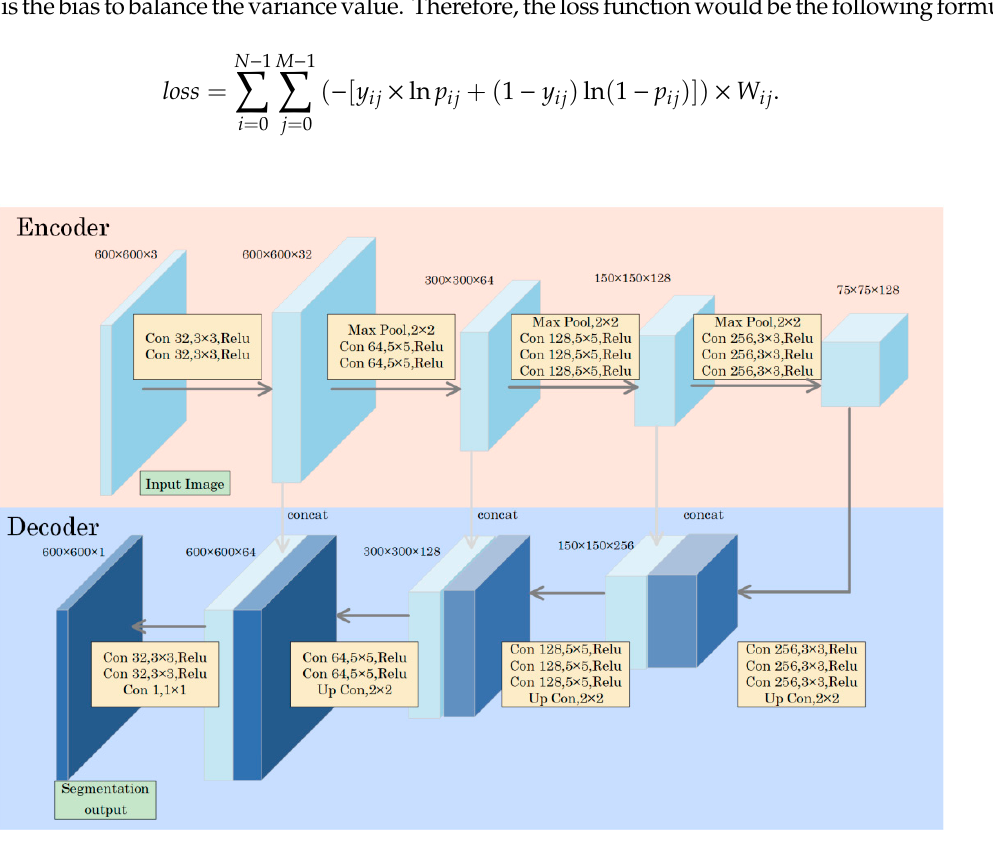
Figure 7. Proposed architecture of the segmentation network.